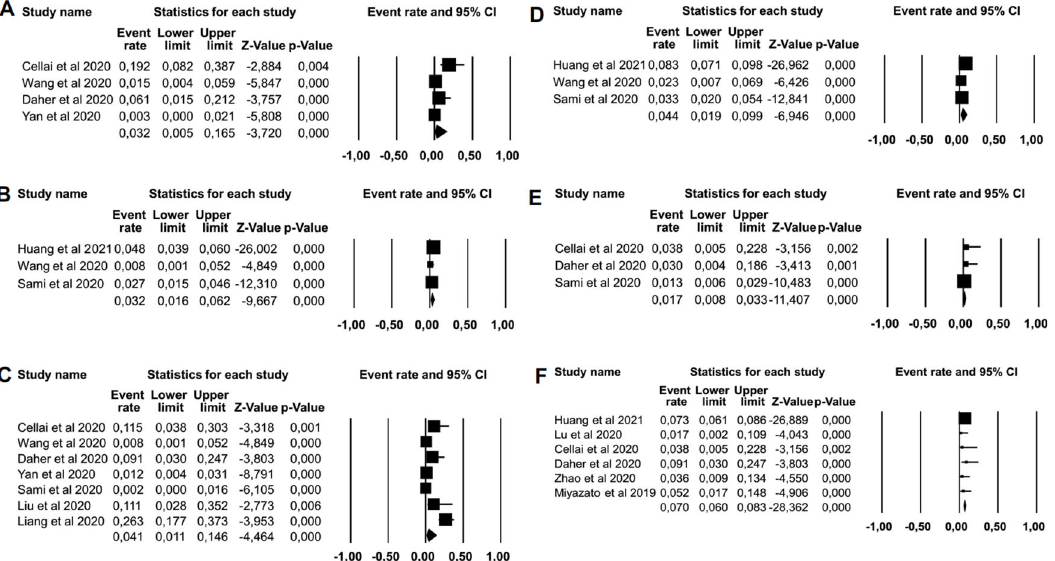
Figure 2. Forest plot of symptoms in long COVID-19 syndrome. (A) Estimated prevalence of prolonged nausea in COVID-19 (event rate 3.23%, 95%CI: 0.54% – 16.53%, p < 0.001, p Egger 1.683, and p heterogeneity <0.001). (B) Estimated prevalence of prolonged vomiting in COVID-19 patients (event rate 3.19%, 95%CI: 1.62% – 6.17%, p = 0.028, p Egger 0.482, and p heterogeneity 0.028. (C) Estimated prevalence of prolonged diarrhea in COVID-19 patients(eventrate4.12%,95%CI:1.07% – 14.64%, p <0.001,p Egger1.726,andpheterogeneity<0.001).(D)Estimated prevalence of prolonged of loss of appetite in COVID-10 patients (event rate 4.41%, 95%CI: 1.91% – 9.94%, p < 0.001, p Egger 0.690, and p heterogeneity <0.001. (E) Estimated prevalence of prolonged of abdominal pain in COVID-19 patients (event rate 1.68%, 95%CI: 0.84% – 3.32%, p = 0.499, p Egger <0.001, and p heterogeneity 0.499). (F) Estimated prevalenceofprolongedofdysgeusiainCOVID-19patients(eventrate7.04%,95%CI:5.96% – 8.30%, p =0.526,pEgger <0.0001, and p heterogeneity